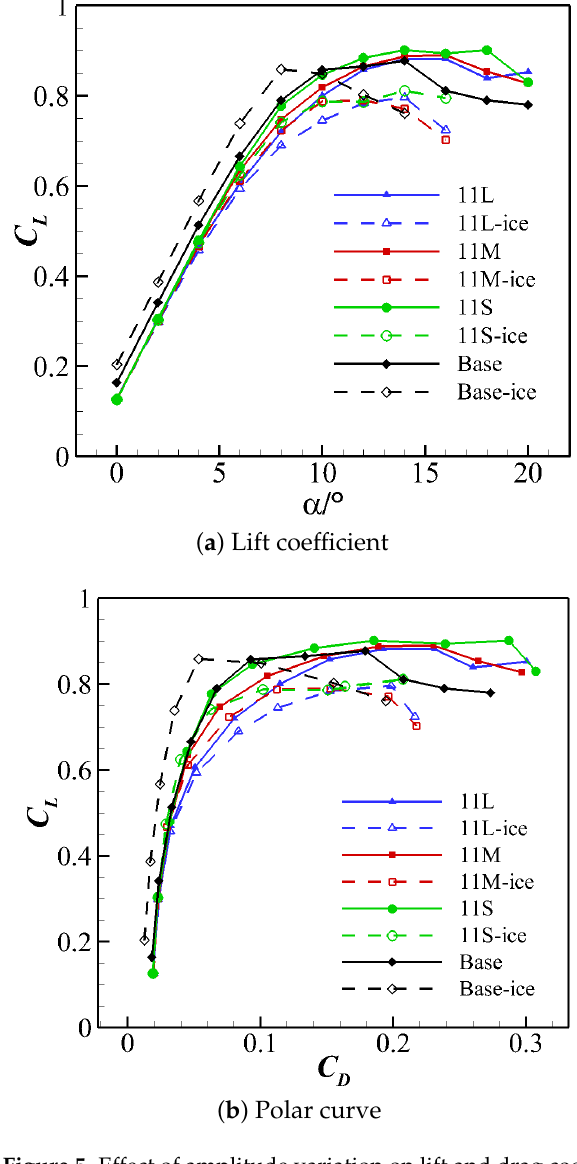
Figure 5. Effect of amplitude variation on lift and drag